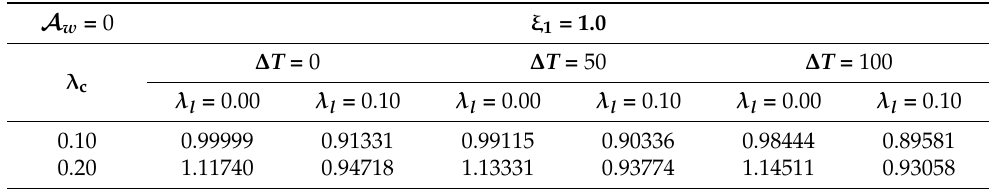
Table 8. Linear dimensionless natural frequencies of porous FG clamped–clamped (C–C) nano-beam for ξ 1 = 1.0. A w =